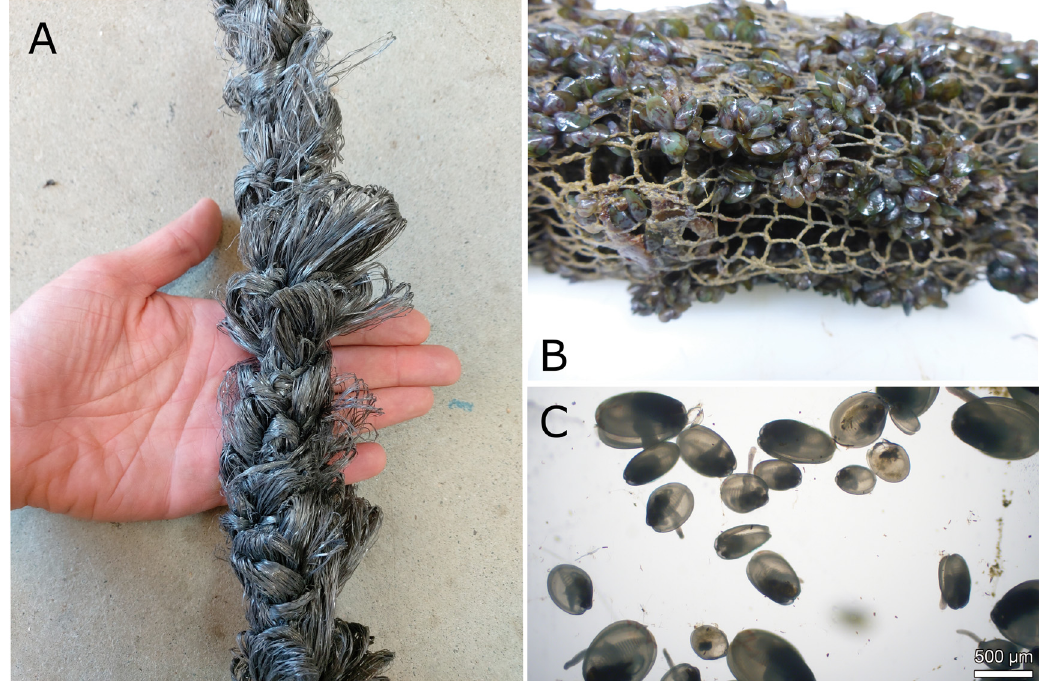
Fig. 2. (A) ‘Xmas tree’ rope used in collectors to sample green-lipped mussel Perna canaliculus spat and (B) a lifted spat monitor- ing line covered in green-lipped mussel spat. (C) Green-lipped mussel spat are retrieved from the ‘Xmas tree’ ropes after 1 wk and taken to the laboratory where they are counted using a binocular microscope. Photo credits: Natali Delorme, Paul